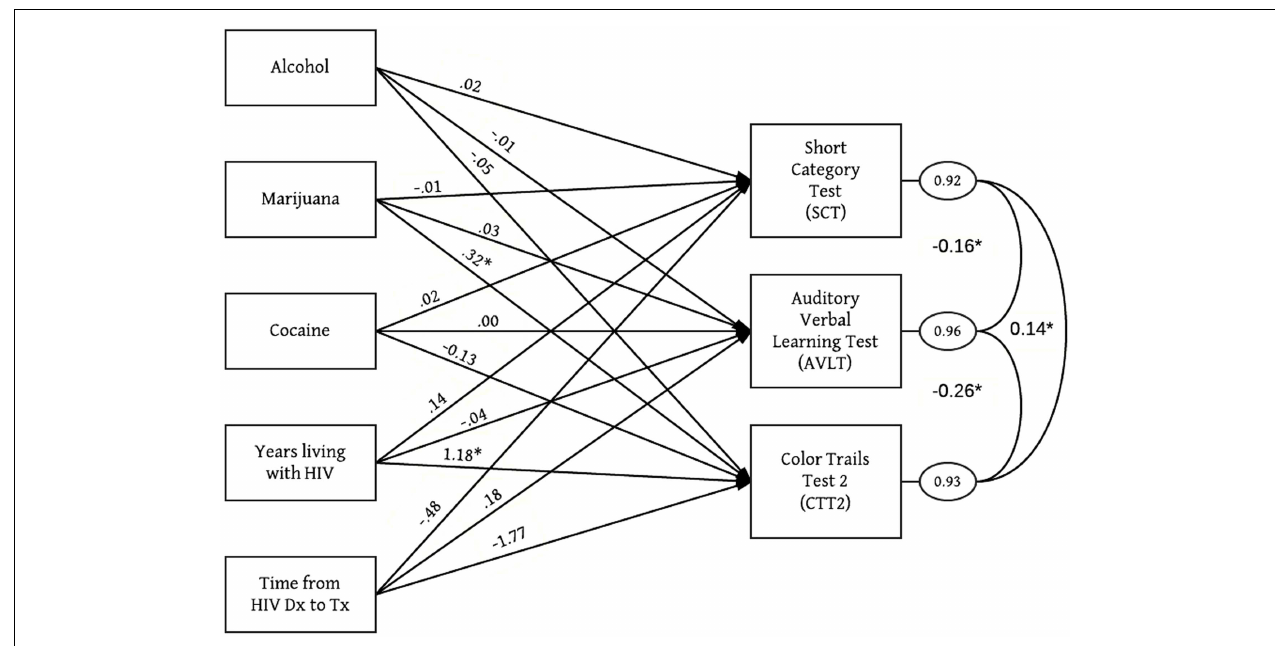
FIGURE 1 | Significant regression paths among measured variables in the structural equation model among HIV-positive alcohol abusers ( N = 370) . Model included age, gender and education level as covariates. Regression coefficients (represented as one-way arrows) are unstandardized. * p <